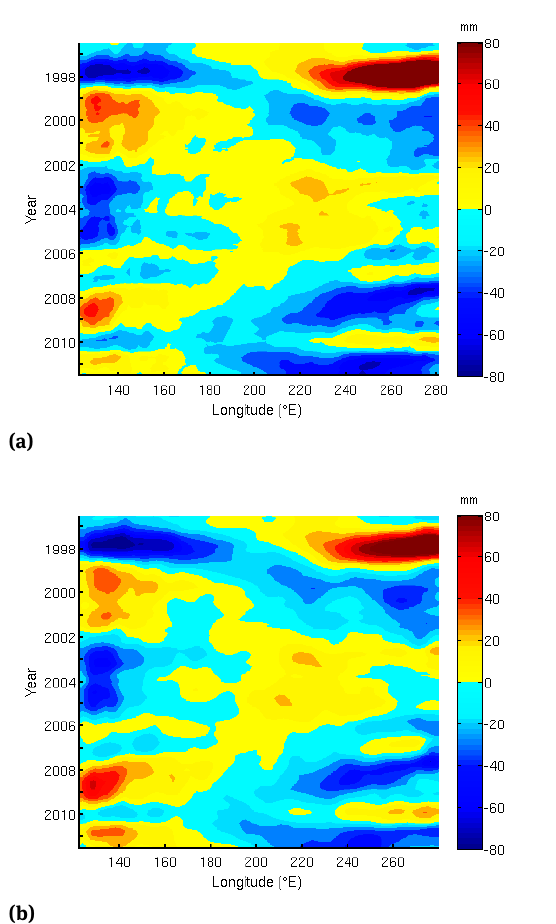
Fig. 7. Longitude/time diagram of the north Pacific (0-60°N) altimetry-based sea level data from 1996 to 2011. Units: mm; Longi- tude/time diagram of the north Pacific (0-60°N) steric sea level data from IK12 from 1996 to 2011. Units: mm.